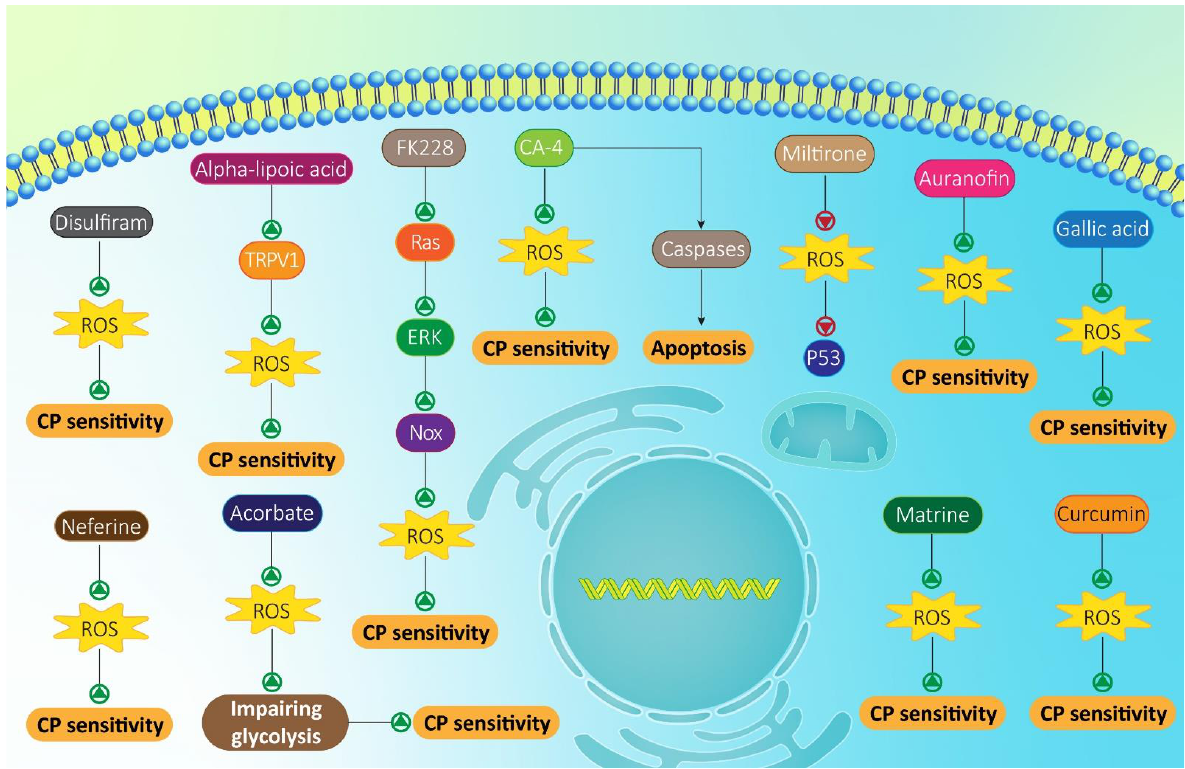
Figure 3. Anti-tumor compounds targeting ROS and mediating CP sensitivity. Most of them are phytochemical and mainly enhance ROS levels in apoptosis induction and promoting potential of CP in cancer suppression.